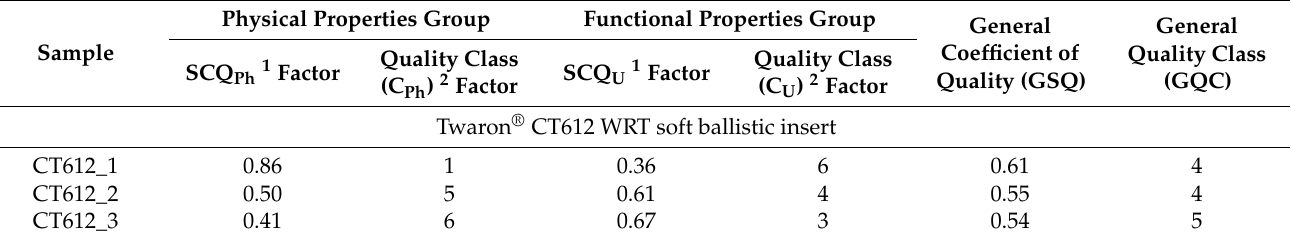
Table 6. Selection of the optimal variants of para-aramid soft ballistic inserts.